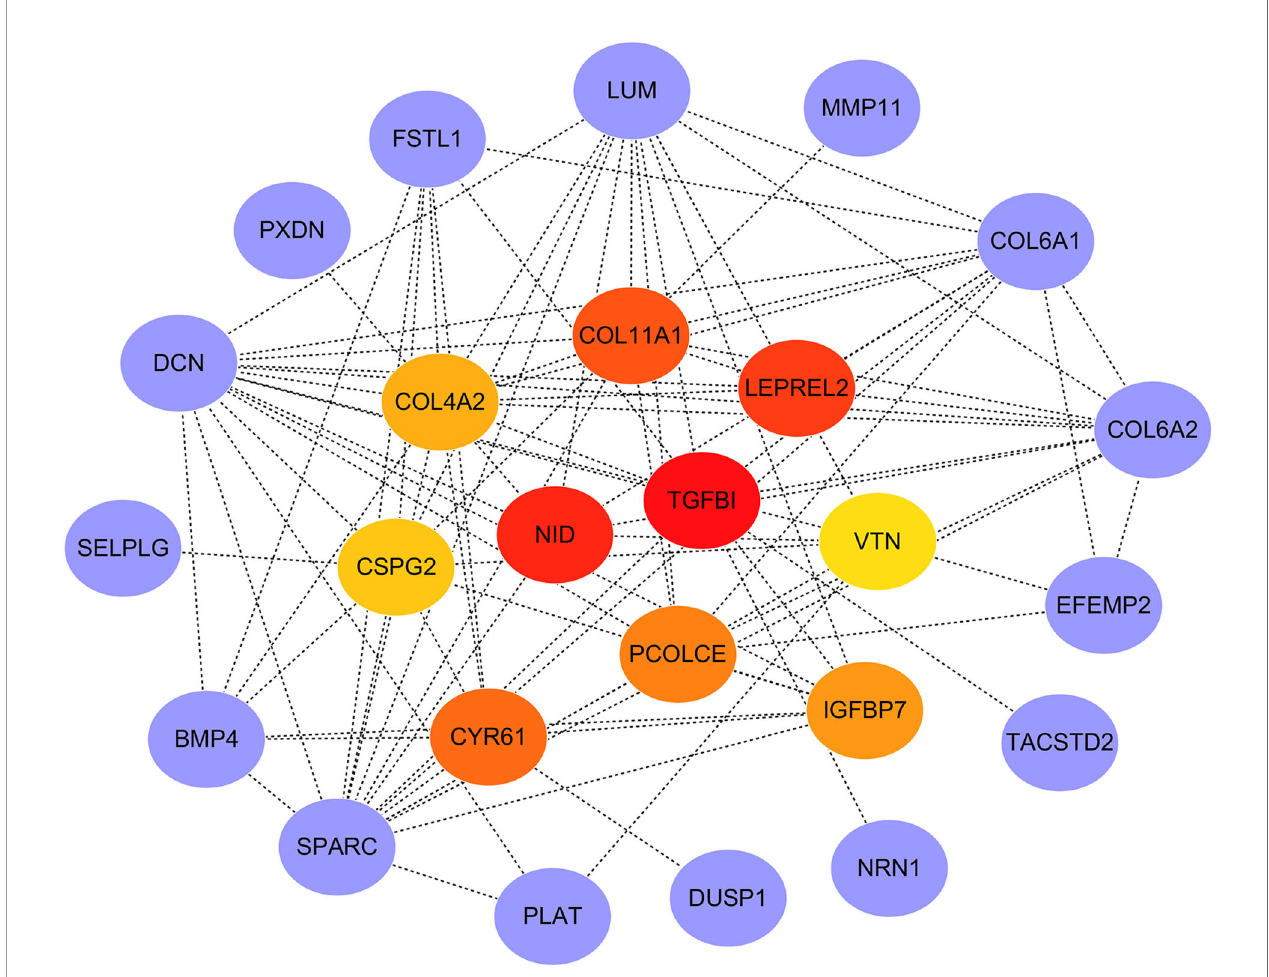
FIGURE 7 | PPI network of genes in the red module and hub gene